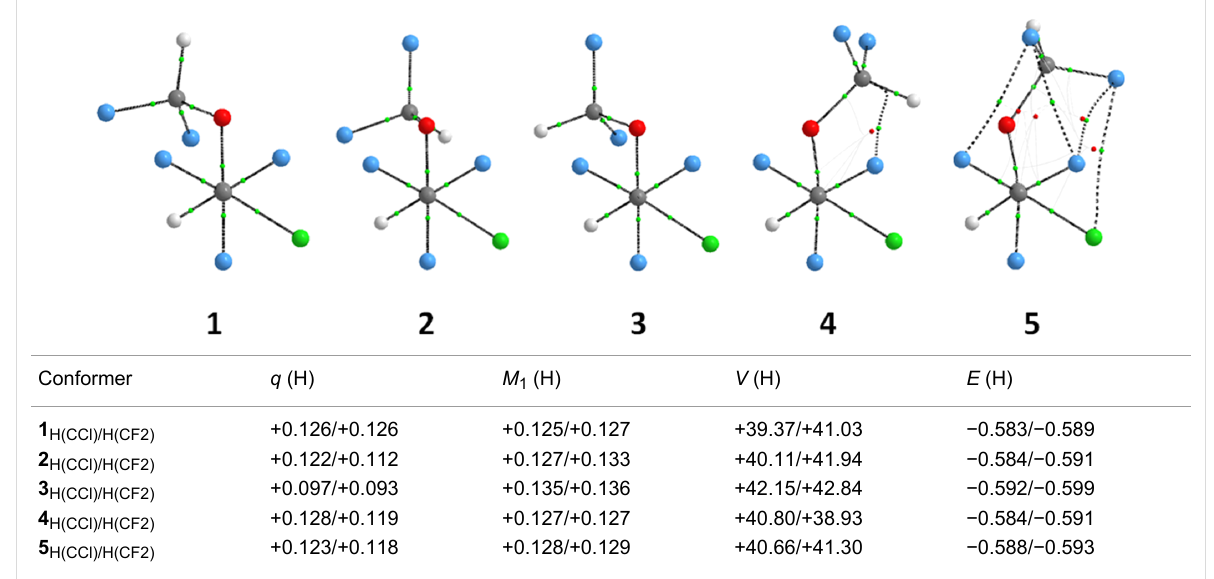
Table 2: Anomeric interactions and relative Lewis and non-Lewis contributions (kcal mol − 1 ) for the conformers of isoflurane, in the gas phase at the ω B97X-D/6-311++g(d,p) level. Conformer